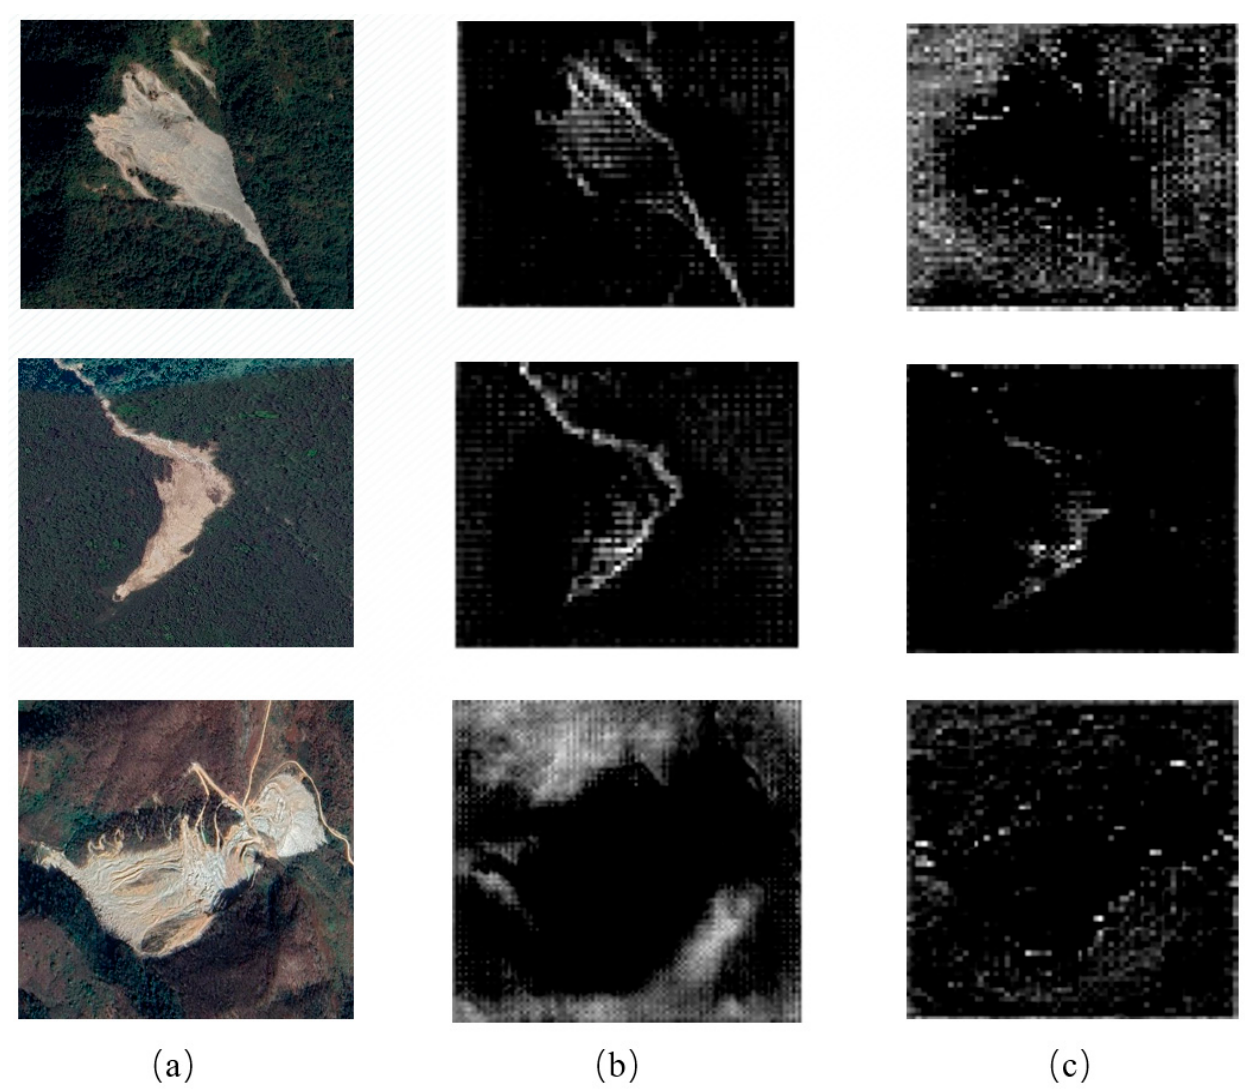
Figure 11. Comparison of the features extracted by the CBAM-Mini network with and without lightweight multiscale fusion. ( a ) Original image, ( b ) features extracted using lightweight multiscale fusion, and ( c ) features extracted without using lightweight multiscale fusion.